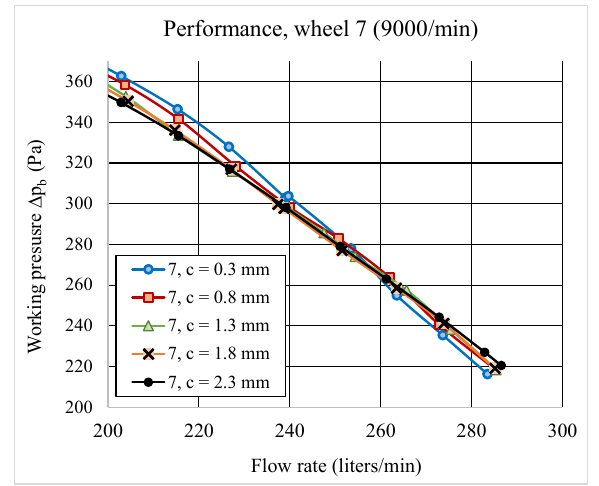
Fig. 11 Fan output for wheel 7 and various mutual position of wheel and the shaft c , maximum flow